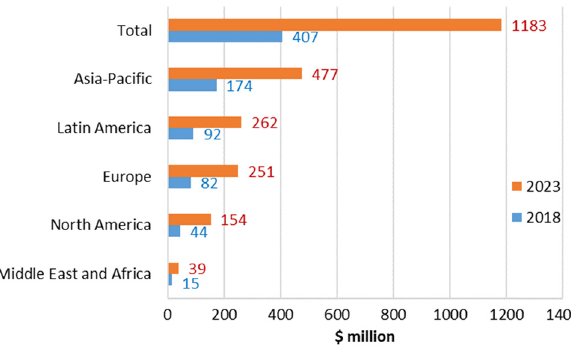
Figure 3: Expected growth of edible insects ’ market value according to the di ff erent